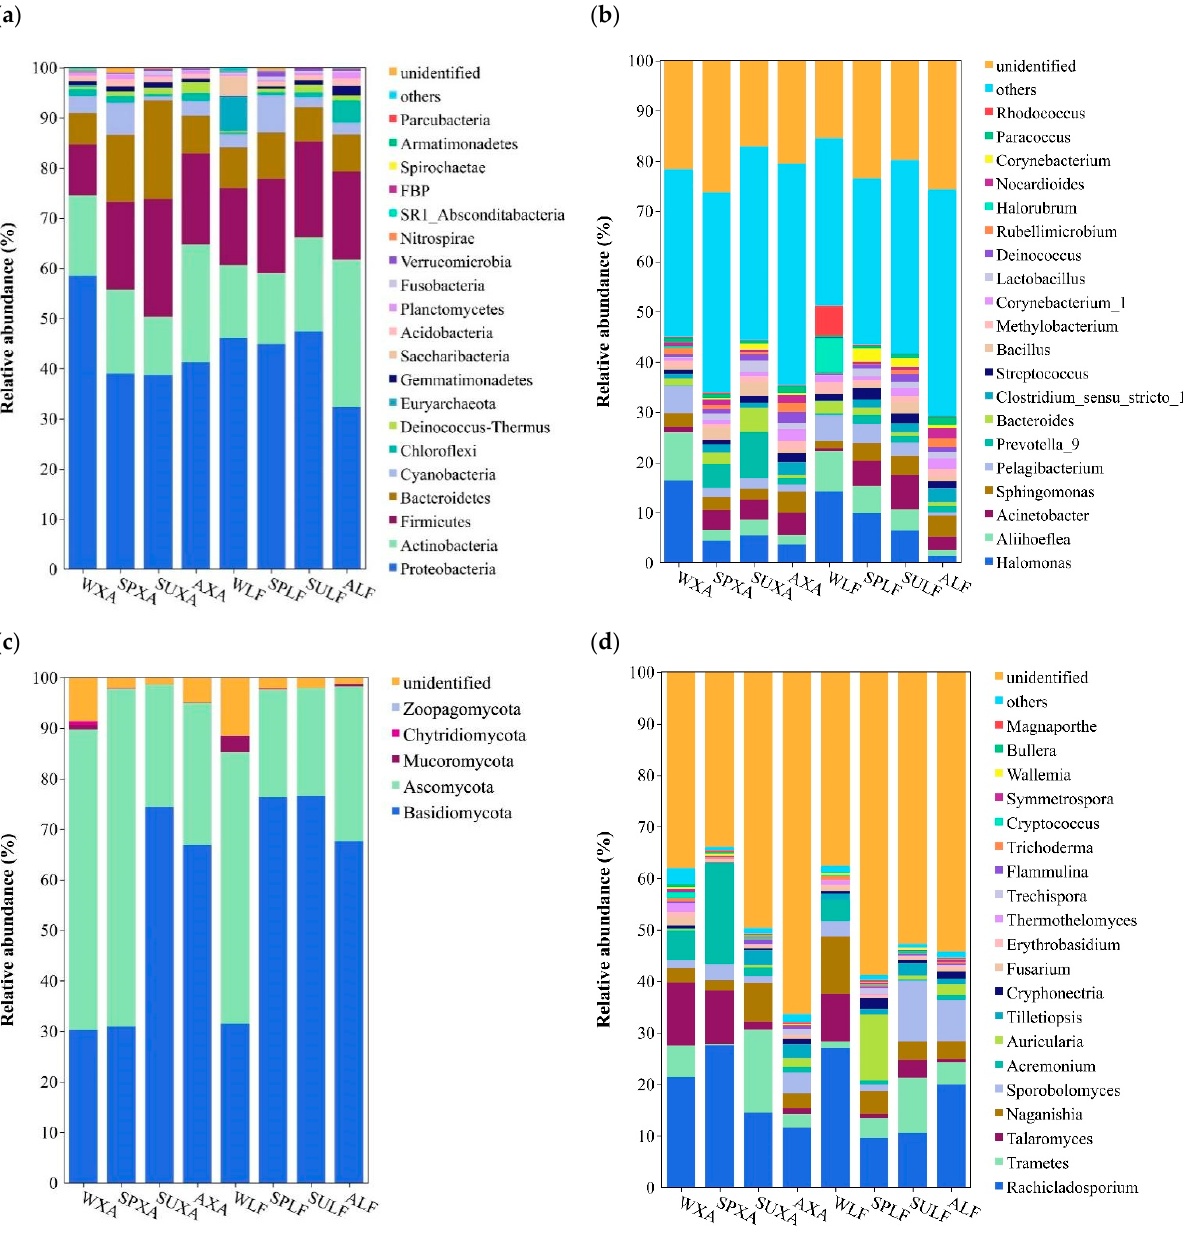
Figure 1. Microbial community compositions of the top 20 abundant OTUs across all PM 2.5 samples in Xi’an and Linfen. ( a ) Bacterial phyla; ( b ) bacterial genera; ( c ) fungal phyla; ( d ) fungal genera. atmospheric environments and wide distribution as primary bacteria in the atmosphere. Proteobacteria was the most abundant phylum (38.70–58.48% (Xi’an); 32.29–47.35% (Lin- fen)), containing a variety of pathogens and nitrogen oxidizing bacteria [53]. In Beijing, Proteobacteria was also the main component across seasons [49]. Most Actinobacteria and